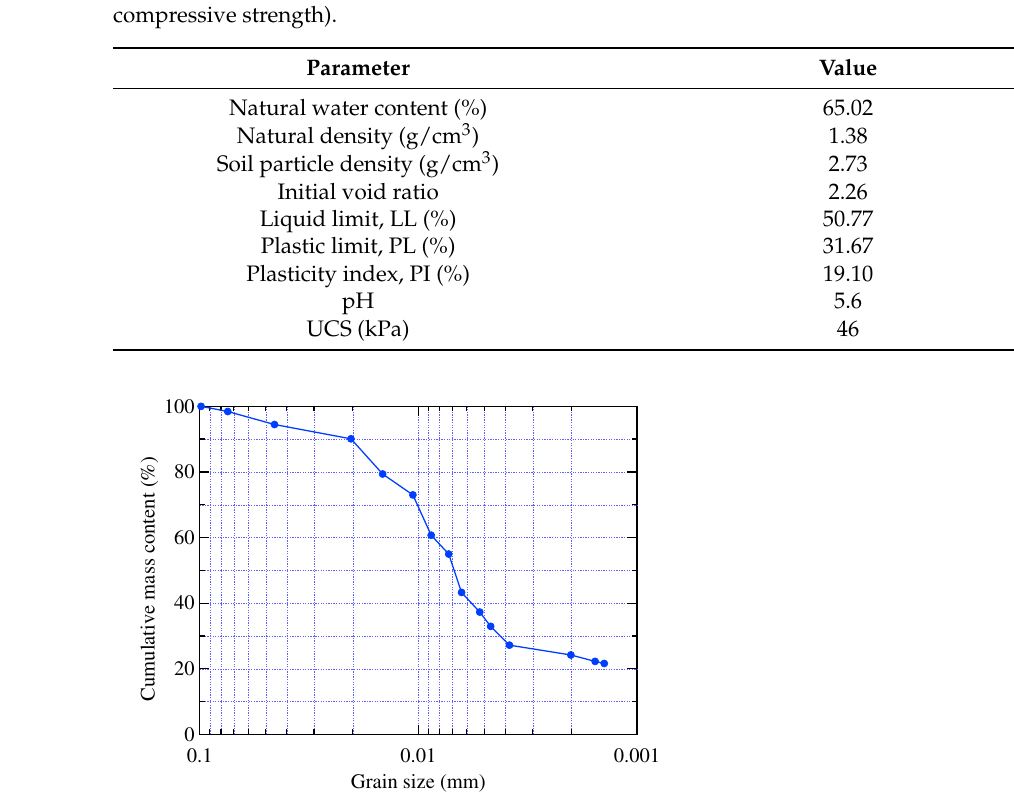
Figure 2. Grain size distribution curve of natural Ningde marine